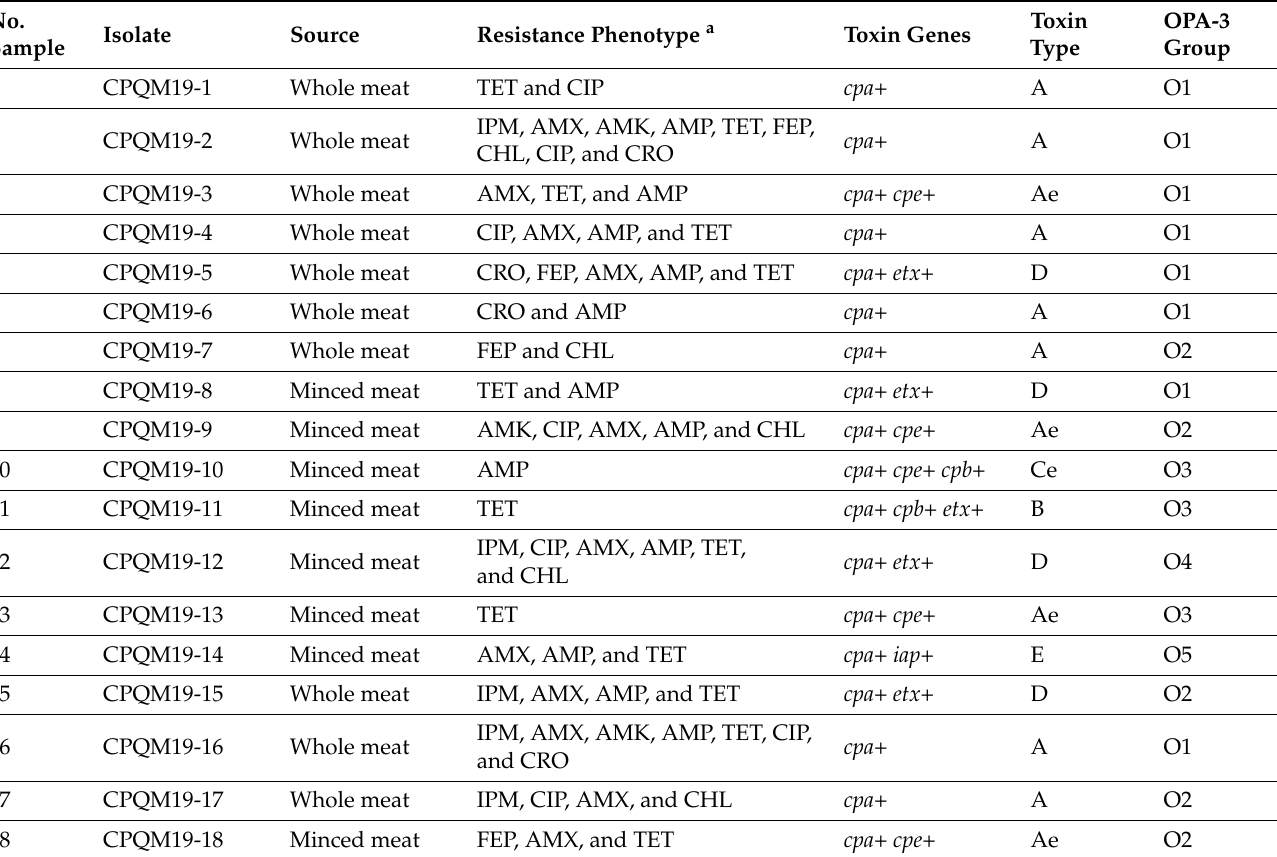
Table 3. Resistance phenotype, toxin genes, toxinotypes and OPA-3 genotypes in C. perfringens isolated from the raw whole and minced meat samples.